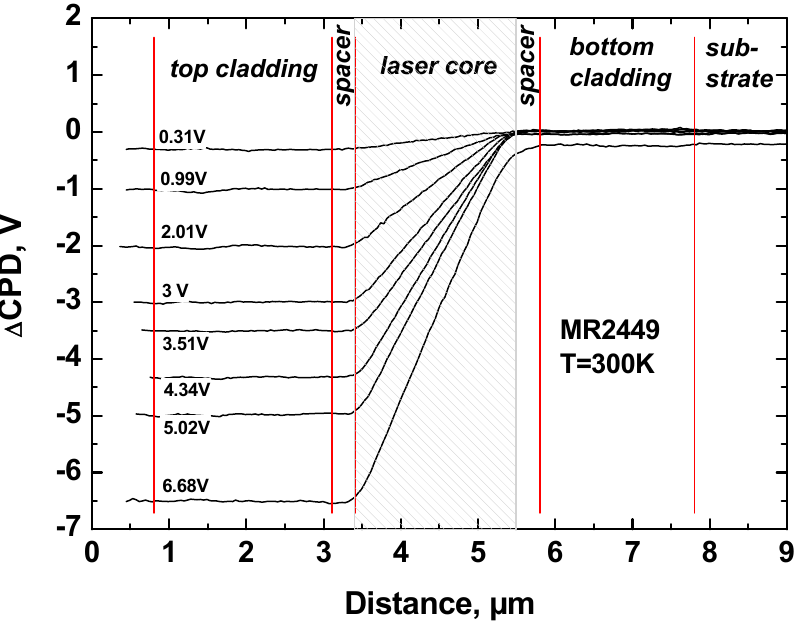
Figure 5. Contact potential di ff erence profiles for the InP-based QCL measured on the cleaved laser facet by KPFM technique for various applied bias.